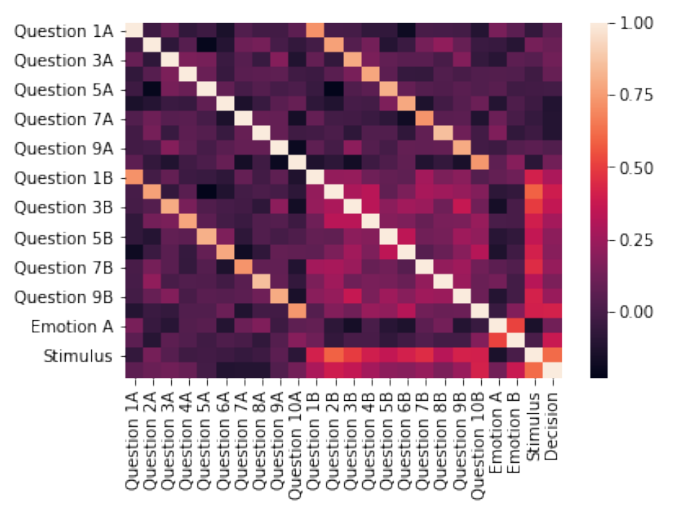
Figure 2. Correlation